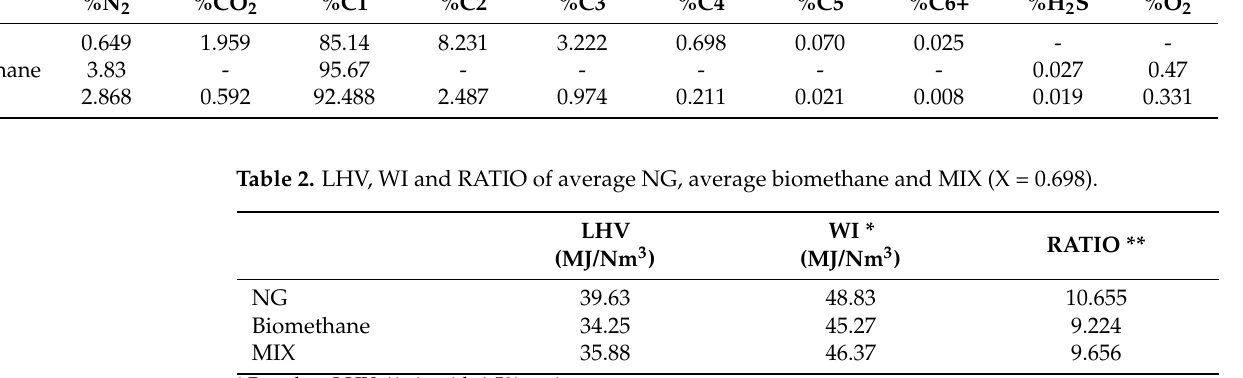
Table 2. LHV, WI and RATIO of average NG, average biomethane and MIX (X = 0.698).